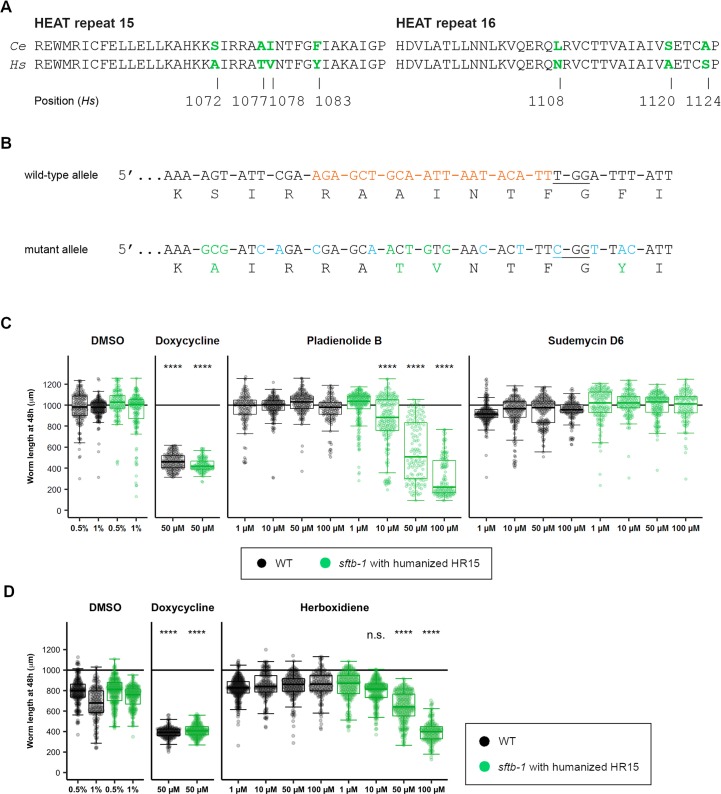
Humanization of the SFTB-1 HEAT repeat 15 confers sensitivity to pladienolide B and herboxidiene.(A) Protein sequence alignment of residues in HEAT repeats 15 and 16. Amino acids that differ between worm SFTB-1 (Ce) and human SF3B1 (Hs) are colored in green. Positions of these residues in the human sequence are indicated. (B) CRISPR/Cas9 design to “humanize” the SFTB-1 HR15. In the wild-type allele, the crRNA sequence used is indicated by orange nucleotides, and the protospacer-adjacent motif (PAM) is underlined. In the mutant (“humanized”) allele, synonymous mutations introduced to prevent partial recombination events and to improve primer specificity for mutant allele detection by PCR are indicated in blue. Missense mutations and the corresponding amino acids are colored in green. (C) Worm length after 48 h of drug treatment at 25°C (n≥120; N = 3). WT animals are represented as black dots, and sftb-1(cer144) mutants as green dots. Doxycycline treatment induced larval arrest in both strains and was used as positive control. Data are shown as Tukey-style boxplots and overlaid dots represent measures in individual animals. The horizontal line at 1000 μm indicates the expected body length of an adult worm. Body length of mutant worms treated with 50 μM doxycycline and 10 μM and 50 μM PB differed statistically from that of mutant worms treated with 0.5% DMSO (p<0.0001). The same applied when comparing mutant worms treated with 100 μM PB and 1% DMSO. Significance was determined with the Kruskal-Wallis test with Dunn’s multiple comparison test. (D) Worm length after 48 h of herboxidiene or doxycycline (control) treatment at 25°C (n≥139; N = 3). Data are represented and analyzed as in panel C (n.s., no significant difference).